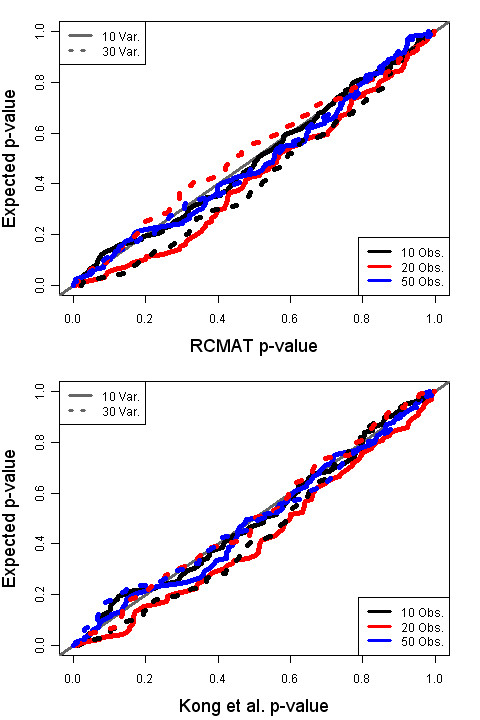
Null distribution p-values. Null distribution p-values for both the RCMAT and the method of Kong et al. under the null hypothesis (no average difference). P-values for 100 simulated data sets within each of six conditions are given. Along the vertical axis is the expected p-value under the assumption of no difference between the two phenotypes; on the horizontal axis is the corresponding actual p-value obtained from the simulation.